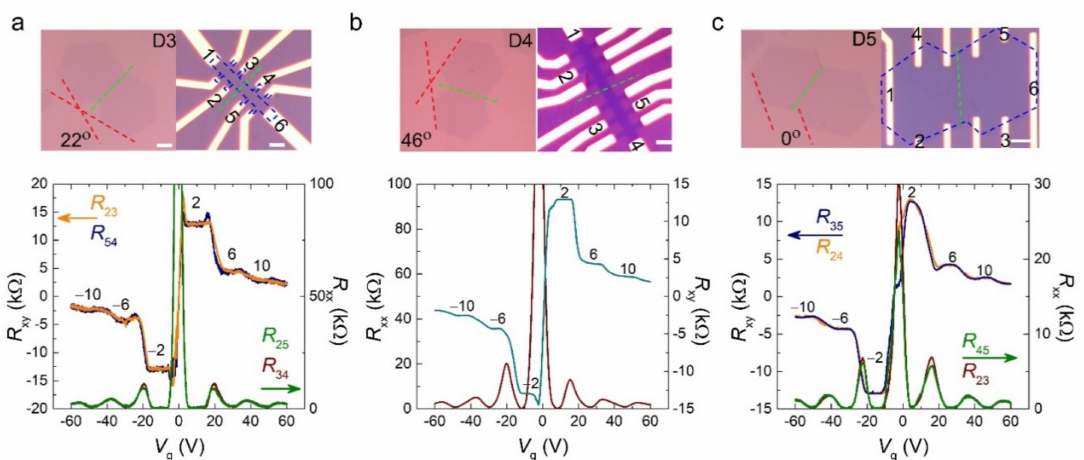
Figure 3. Quantum Hall (QH) state of grain boundary (GB) graphene device at different stitching angles. ( a – c ) Optical microscopy image of the device (top) and gate voltage ( V g ) dependence of R xx and R xy (bottom) of the devices with stitched angles 22 ◦ , 46 ◦ , and 0 ◦ , respectively. The graphene channel, GB, and stitching angle are denoted by the blue, green, and red dashed lines, respectively. The data were measured at 14 T and 2 K with an applied current of I ds = 1 µ A. The scale bars are 4 µ